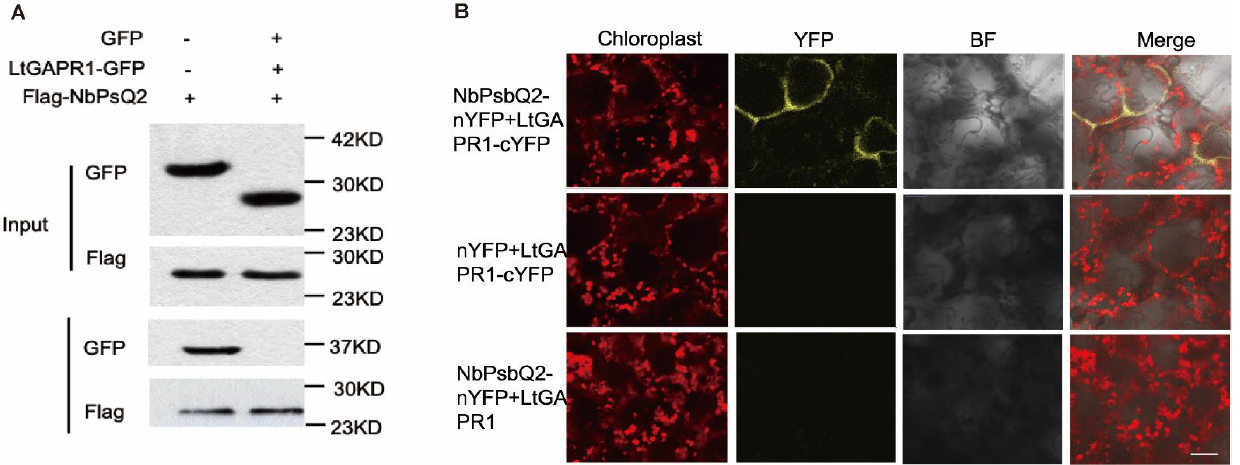
Figure 3. LtGAPR1 interacts with NbPsQ2. ( A ) Interaction analysis of LtGAPR1 with NbPsbQ2 via the Co − IP assay. ( B ) Interaction analysis of LtGAPR1 with the NbPsbQ2 assay via split YFP assays. Agrobacterium tumefaciens expressing p35S:nYFP − NbPsbQ2 and p35S:cYFP − LtGAPR1 were co − infiltrated into 4 − week − old Nicotiana benthamiana leaves. The images were taken using a confocal laser scanning microscope at 2 days post infiltration (dpi). Bar = 50 μm.